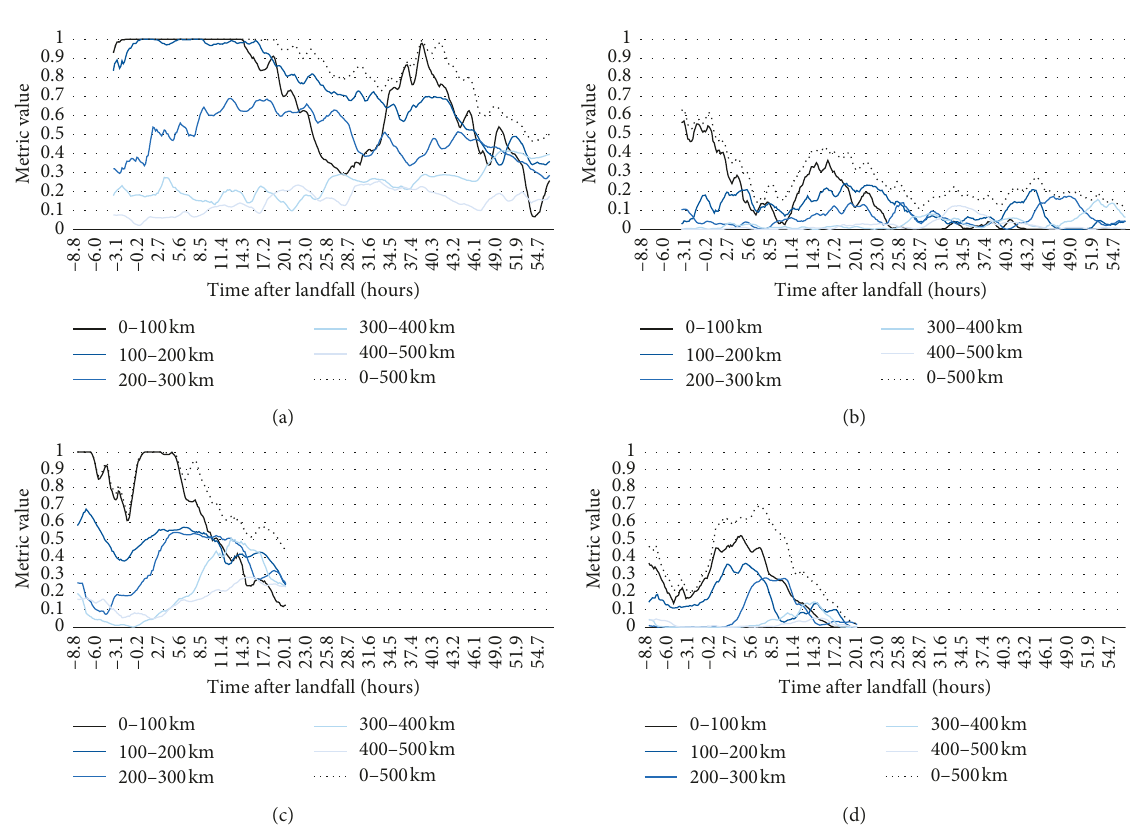
The two values in italics are not statistically significant at the 0.01